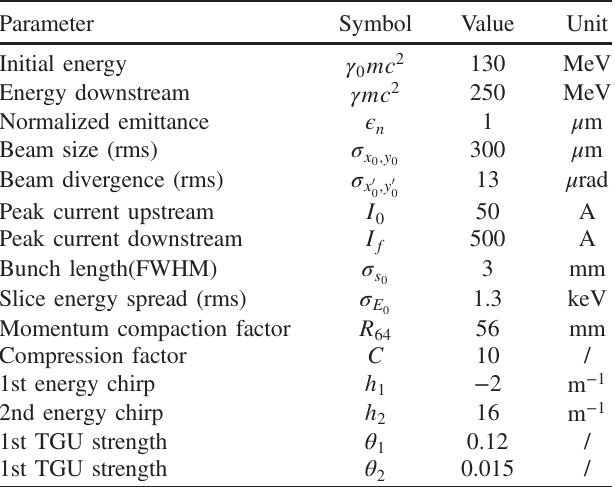
TABLE I. The beam and lattice parameters.